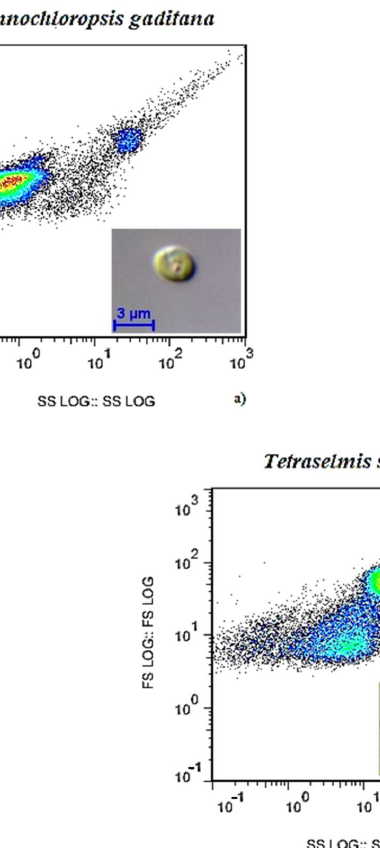
Figure 8. Size as a function of complexity for each of the phytoplankton species, obtained by flow cytometry: ( a ) Nannochloropsis gaditana ; ( b ) Isochrysis galbana ; ( c ) Tetraselmis suecica